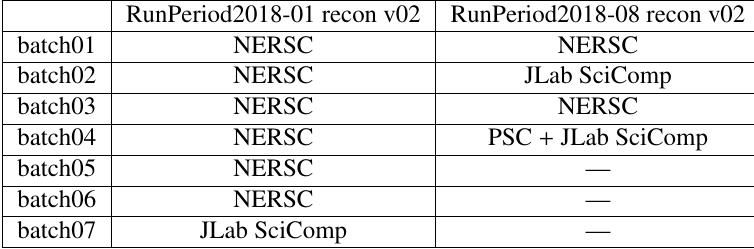
Table 2. Locations where reconstruction was performed for 2018 GlueX data. For each run period, the data was broken up into batches for processing that are roughly equal in size.